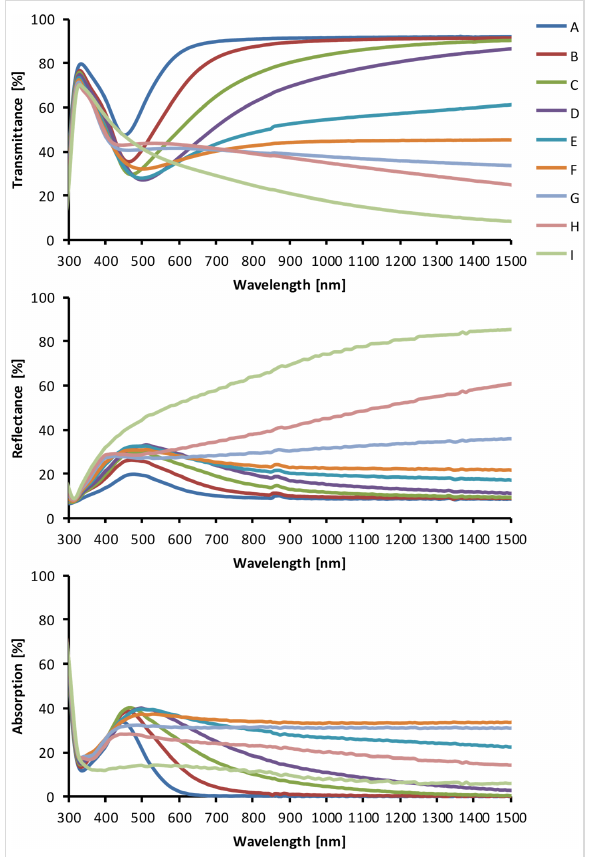
Figure 3: Transmittance, reflectance and absorption spectra of A– I SSF films.